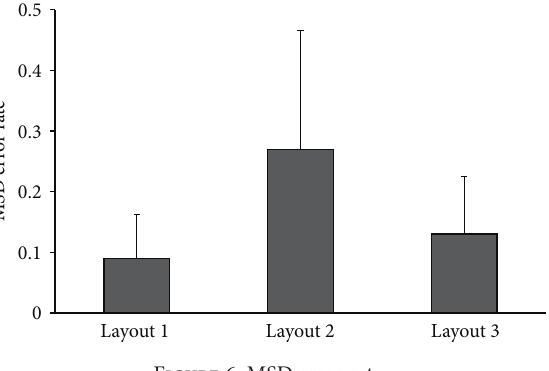
Figure 7: KSPC values.